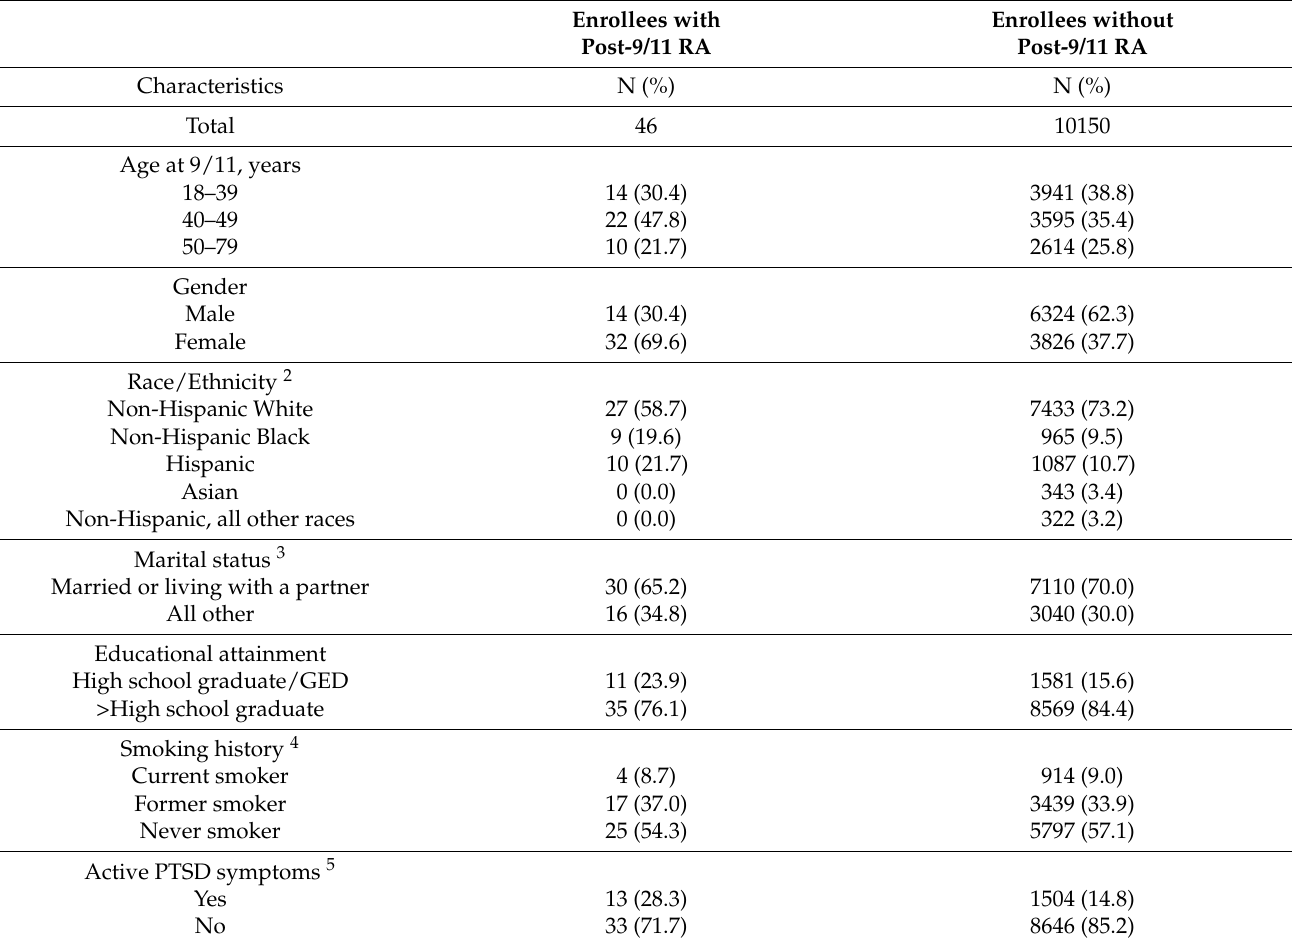
Table 1. Sociodemographic characteristics, active PTSD symptoms, and pain medication overuse